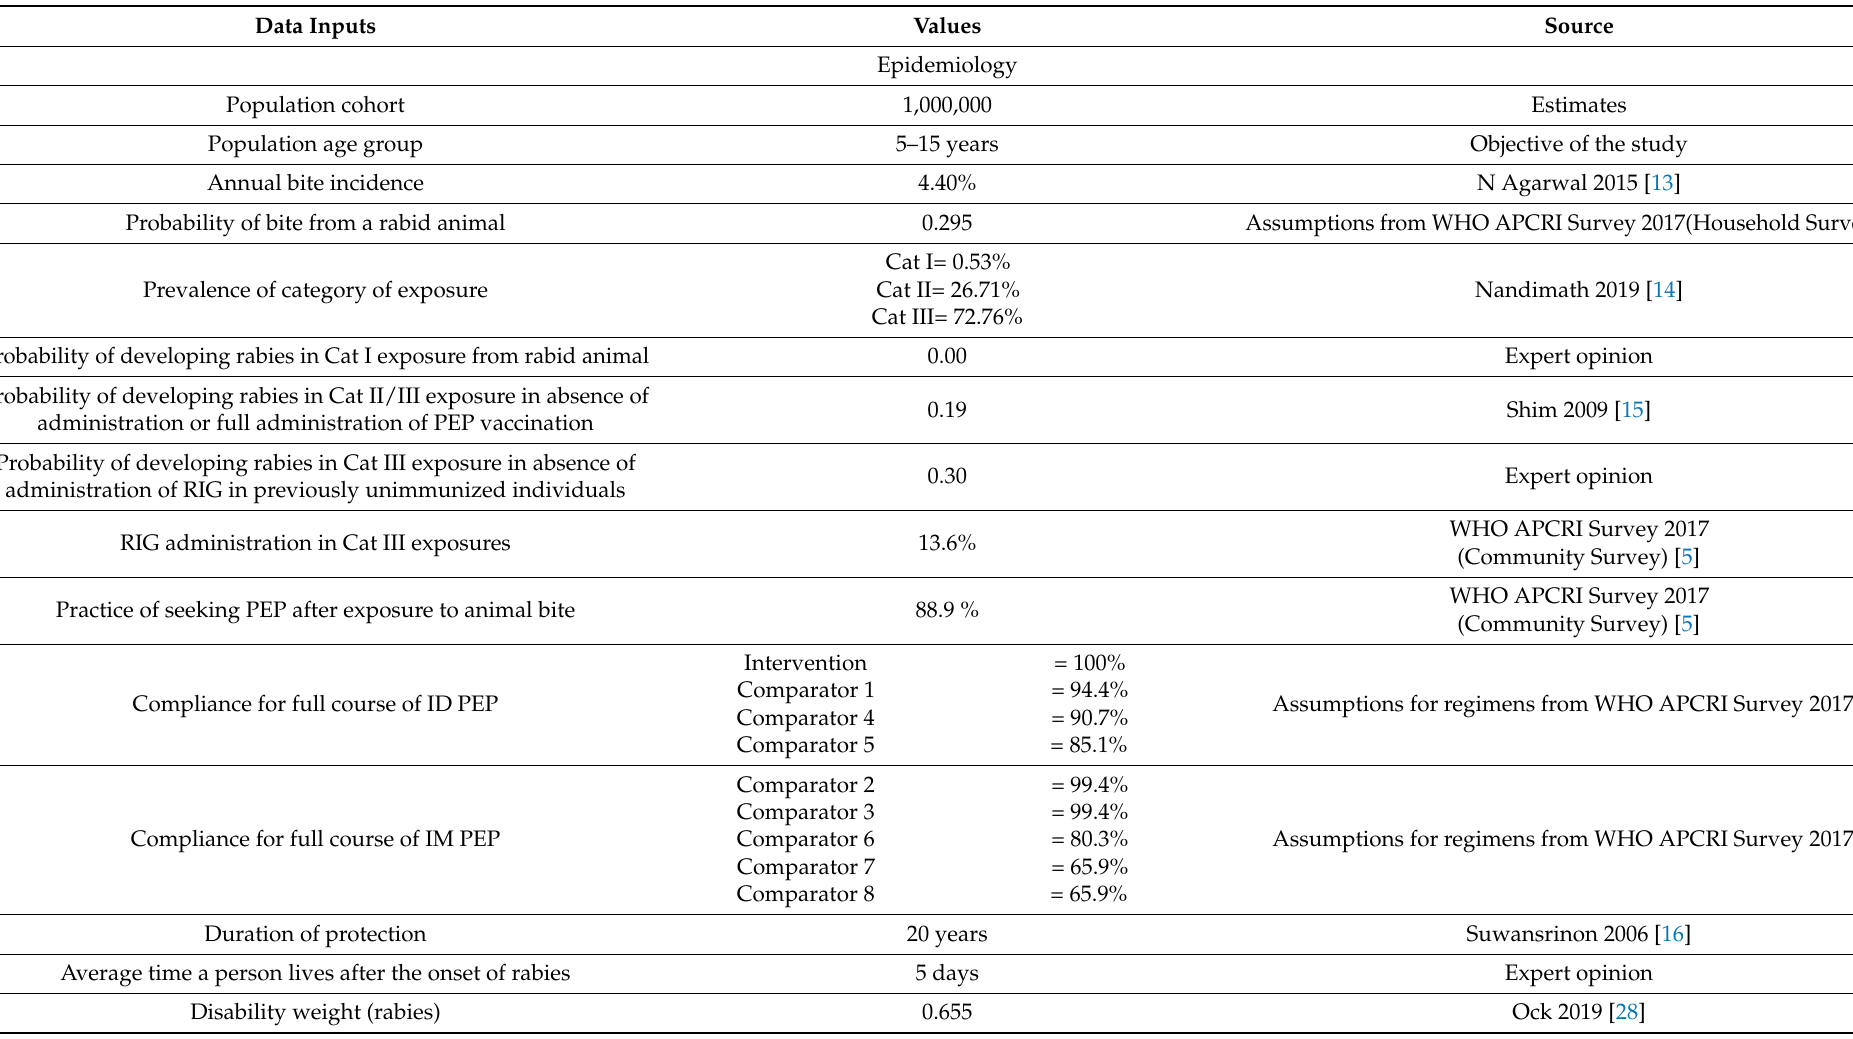
Table 2. Data Inputs for